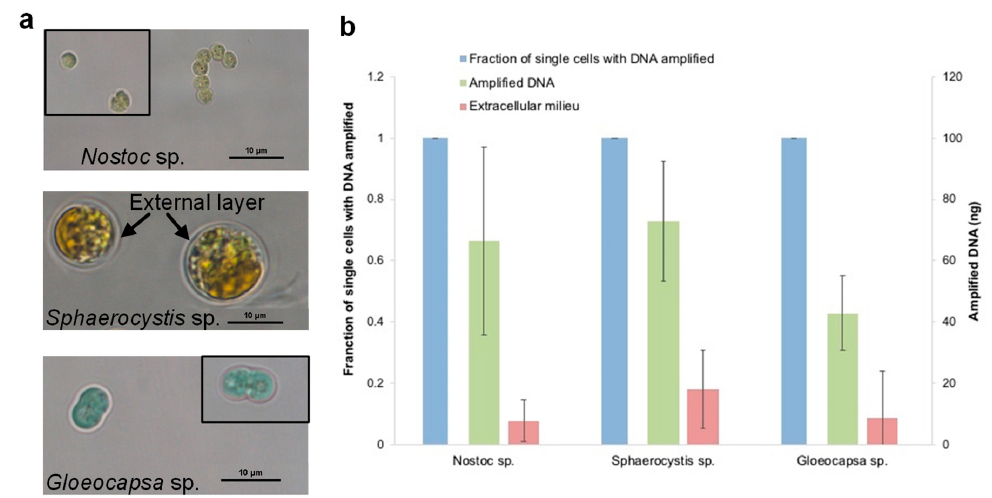
Figure 9. ( a ) Microscopic images of Nostoc sp., Sphaerocystis sp. and Gloeocapsa sp. The black boxes indicate additional cells from another capture to representatively illustrate cells in suspension. ( b ) The use of the developed lysis protocol on Sphaerocystis sp. and Gloeocapsa sp. for lysis and SC-WGA. N = 10 single cells per species per condition; error bars represent standard deviation. Each set of experiment was repeated three times. The sterile PBS as a true negative control did not show any contamination after amplification (not shown in the graph).